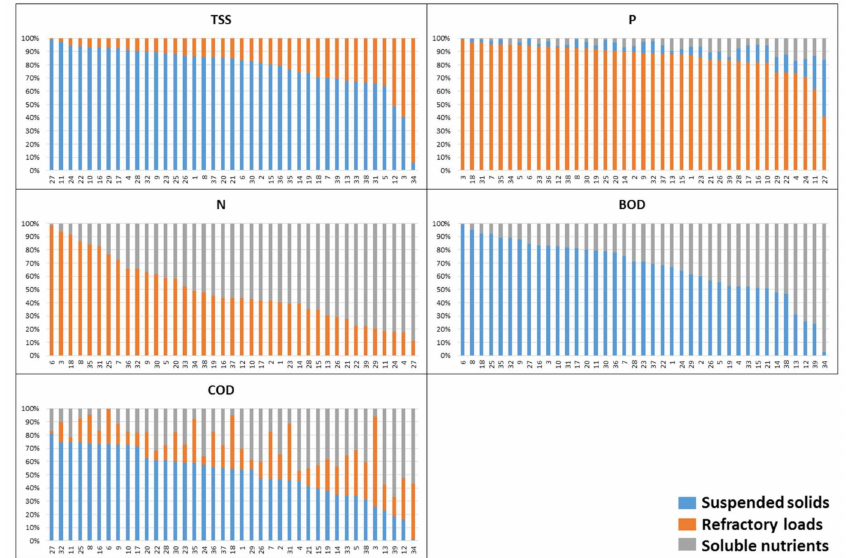
Figure 3. Source contributions to WWTP e ffl uent loads for each WWTP.